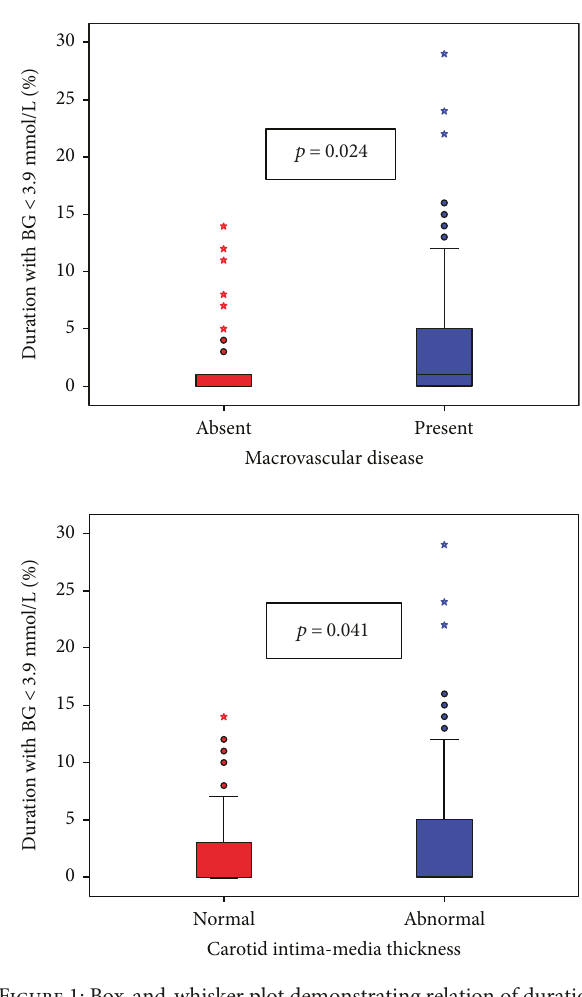
Figure 1: Box-and-whisker plot demonstrating relation of duration of glucose < 3.9mmol/L (expressed as percentage of the entire 72hr period) and macrovascular disease and carotid intima-media thickness. ∗ denoting